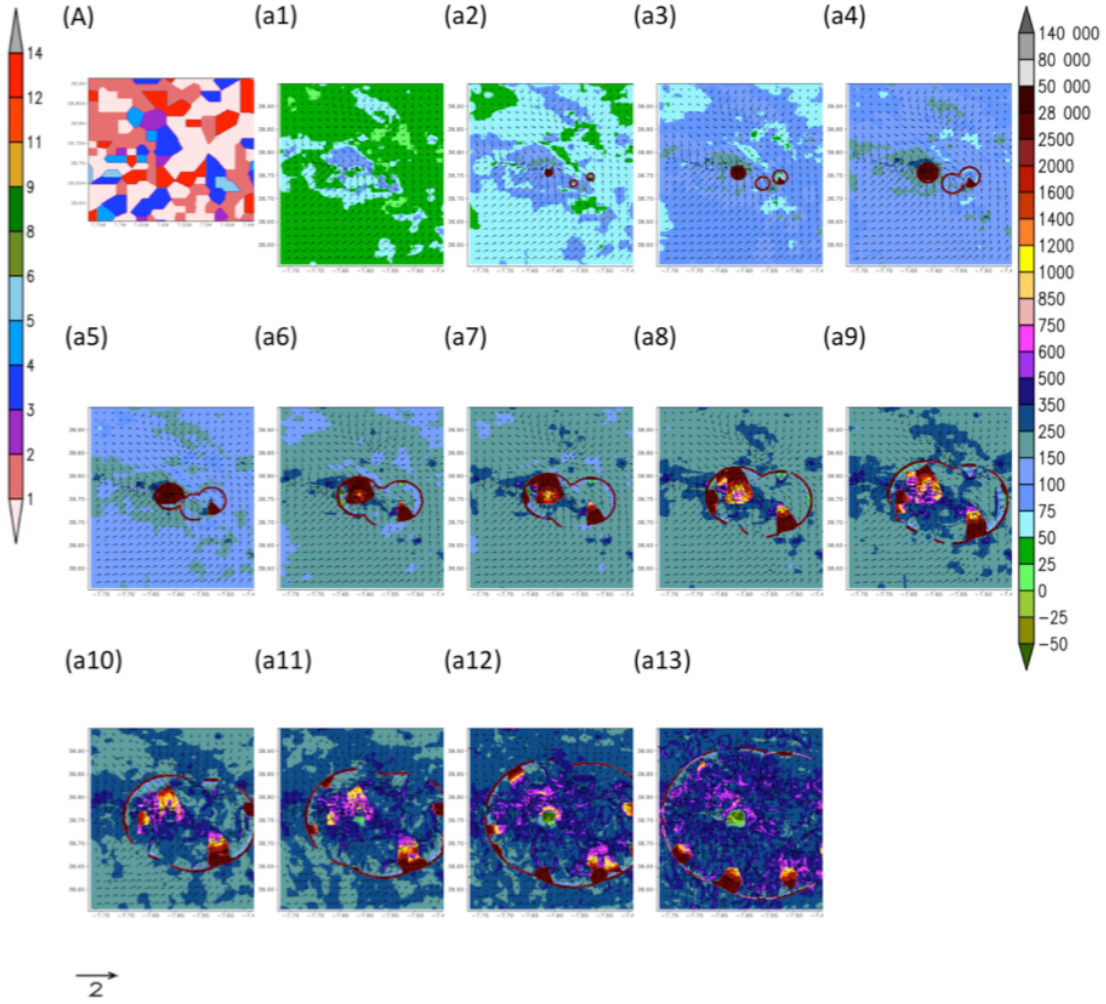
Figure 23. (a) Fuel models of the Ossa mountain range region. The panels from a1 to a13 show sensible heat fluxes (Wm − 2 ) during the fire-line spread and behavior of horizontal atmospheric wind (ms − 1 ) at the surface under the influence of the fire in different moments of forest fire that occurred on 7 August 2006 in the Ossa mountain range in Alentejo in Portugal, simulated by BRAMS-SFIRE. The fuel model range is expressed in the left-side bar color and sensible flux range in the right-side bar